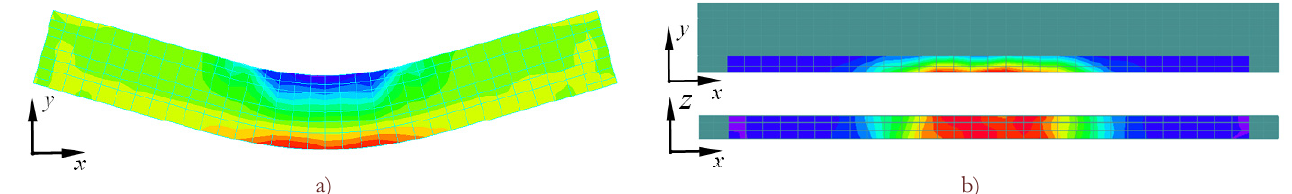
Figure 6: Collapse mechanism of the specimen F-SB: a) contour plot of the strain rate components   c the deformed configuration of the beam; b) contour plot of the strain rates